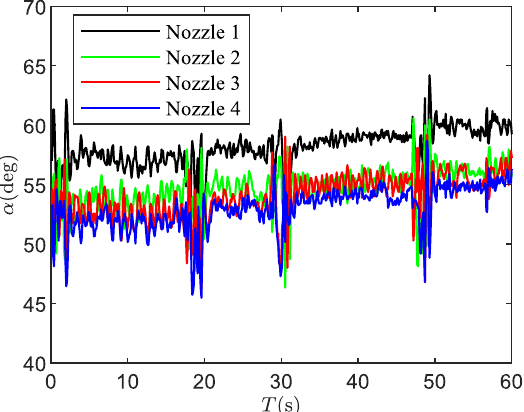
Figure 19. Changes in the angles of the nozzles during flight.